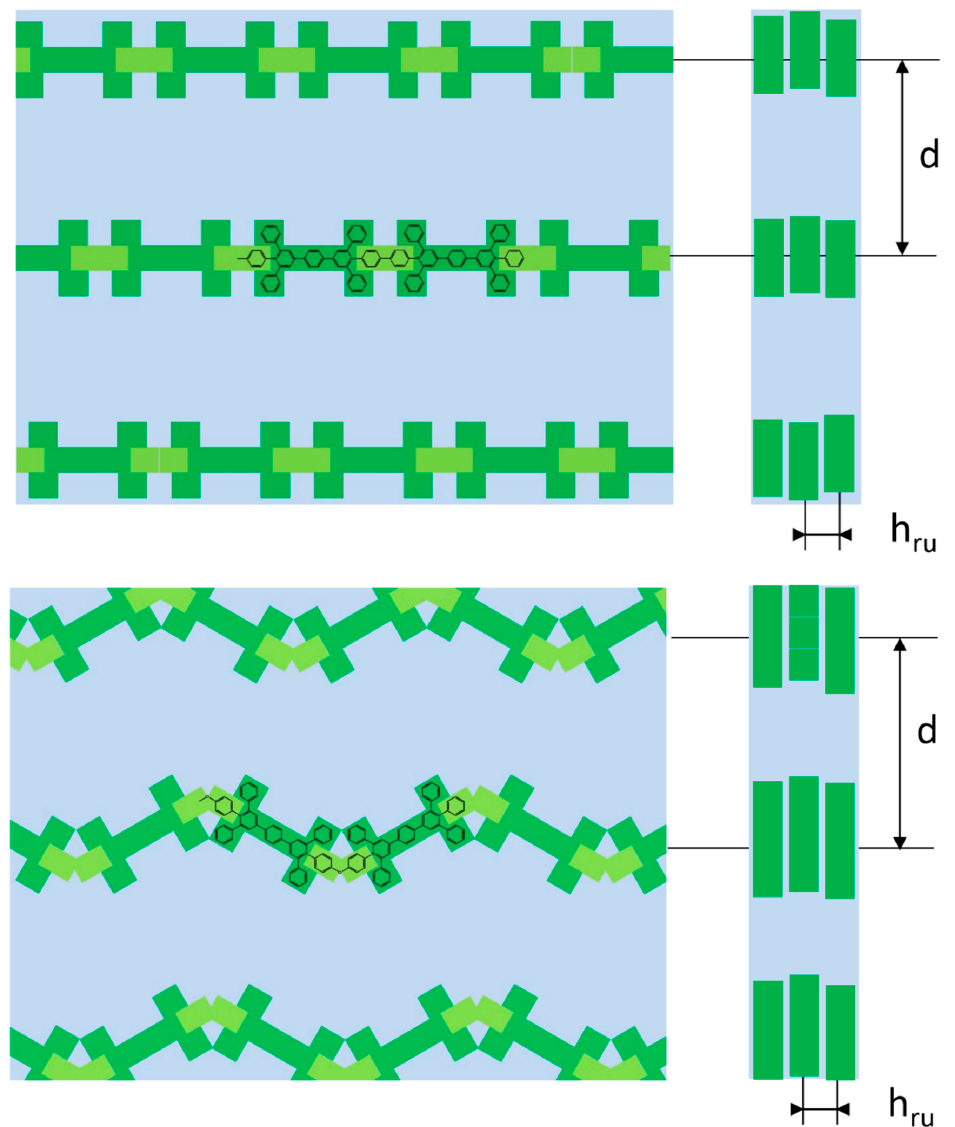
Figure 7. Schematic representation of the lamellar structures of both polymers II-1 (top) and II-2 (bottom). The blue background represents the molten pegylated and aliphatic chains of the macroion, d, the lamellar periodicity and h ru , the average distance between parallel polymeric backbones.